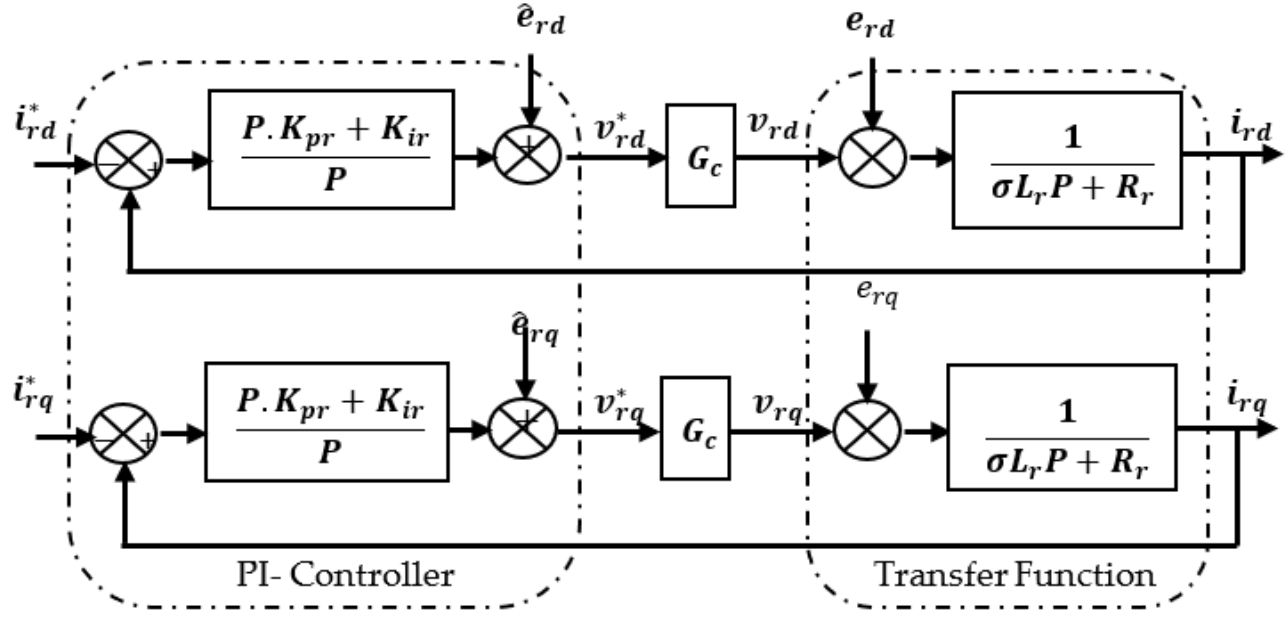
Figure 5. RSPC PI controller setup showing generator speed and stator reactive power control.